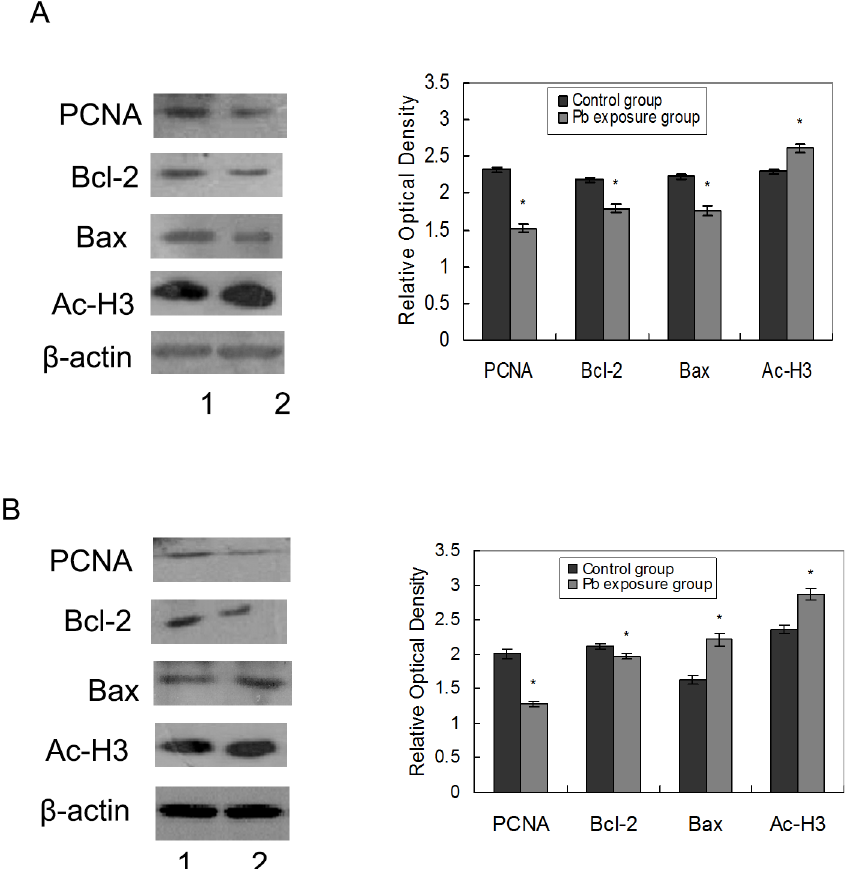
Fig 3. Effects of Pb on vascular tissue protein expression. Effects of Pb exposure on the protein expression of PCNA, Bcl-2, Bax, and acetyl-H 3 in abdominal and thoracic aorta tissue at 12 days after Pb exposure (A) and 40 days after Pb exposure (B). The corresponding bar graphs represent densitometric quantification. n = 6 experiments. Probability values are indicated above bars: * p < 0.05 versus control. 1 stand for control group, 2 stand for Pb exposure